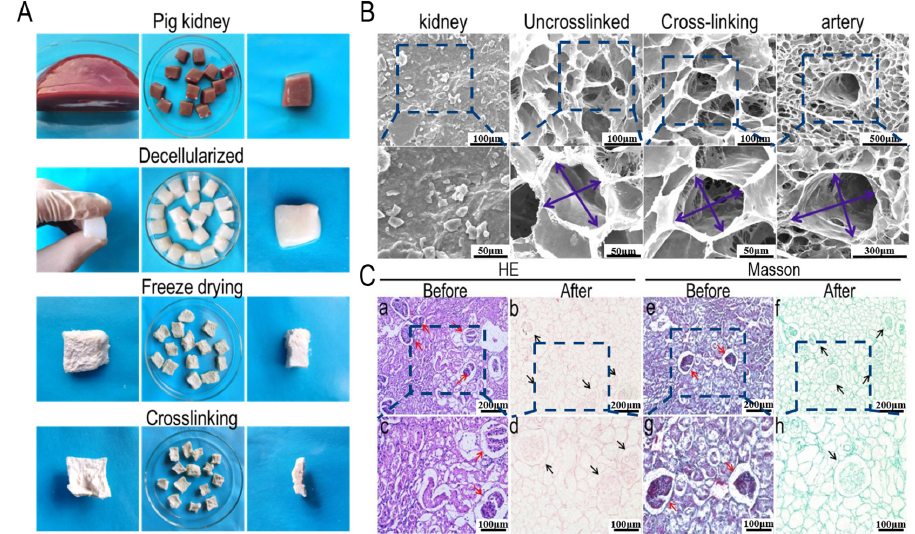
Figure 1. Decellularization efficiency of porcine kidney tissues. ( A ) Macrostructure of pig kidney matrix before decellularization, after decellularization and after crosslink; ( B ) SEM analysis of pig kidney matrix, uncrosslinked dECM, crosslinked dECM,and vascular structure of dECM; ( C ) H&E and Masson staining. ( a , b ) represent H&E staining of procine kidney matrix before and after decel- lularization, respectively. ( c , d ) represent Masson staining of procine kidney matrix before and after decellularization, respectively. ( e ), ( f ), ( g ) and ( h ) are magnification images of ( a ), ( b ), ( c ) and ( d ). scale: 200 μ m (top), 100 μ m (under).